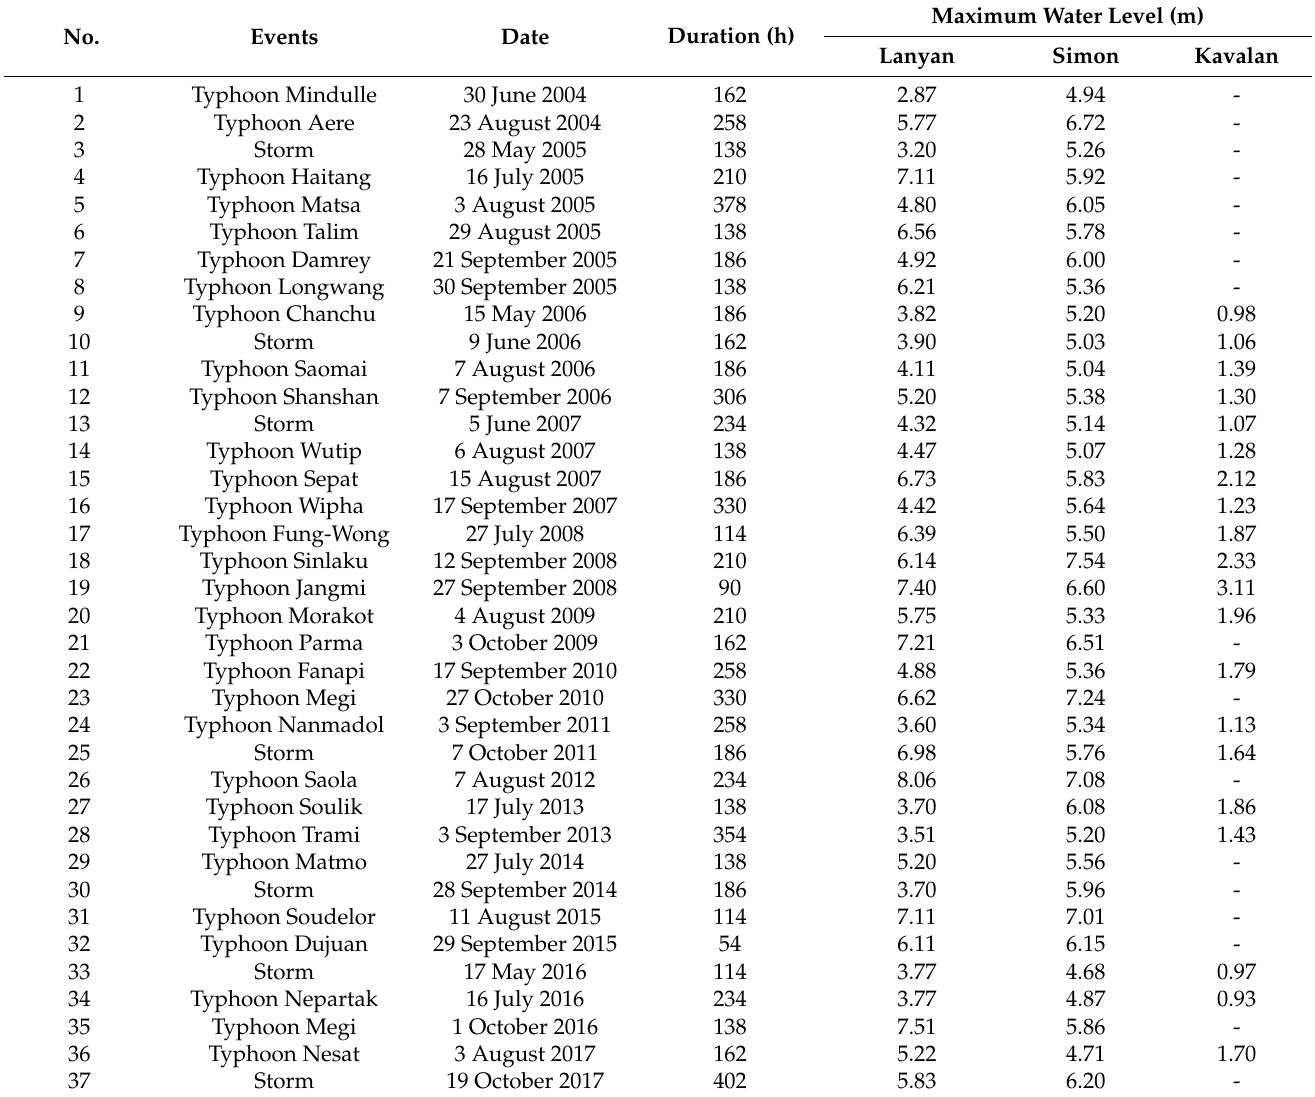
Table 1. The information of the collected hydrology data in the study area.